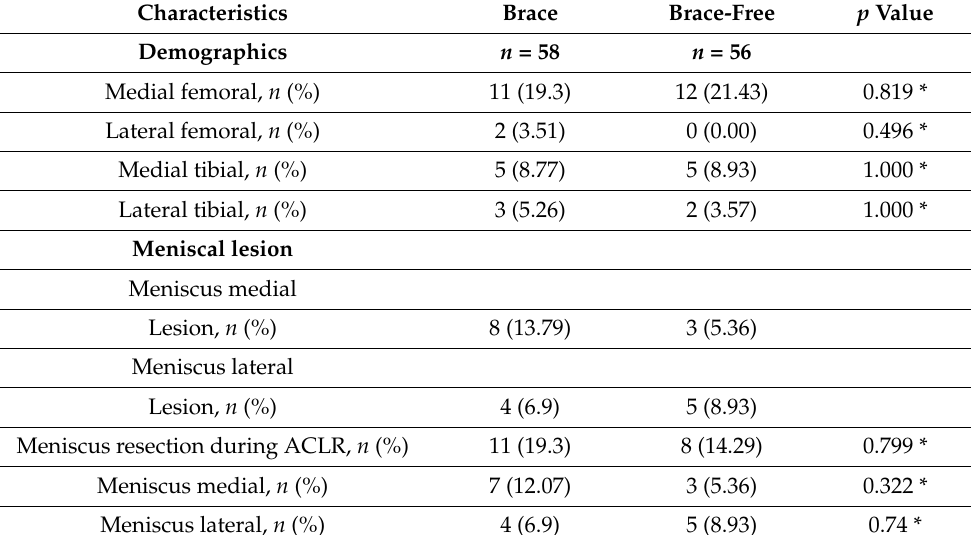
Table 2. Sports level activity preoperative and return to sports after rehabilitation. Sports Level n Brace Brace-Free